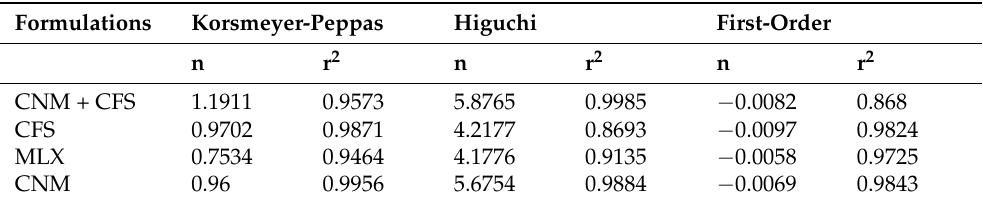
Table 3. Korsmeyer–Peppas, Higuchi, and first-order kinetic models applied for MLX release from MLX raw material and multiparticulate colonic systems CNM + CFS, CFS and CNM at pH